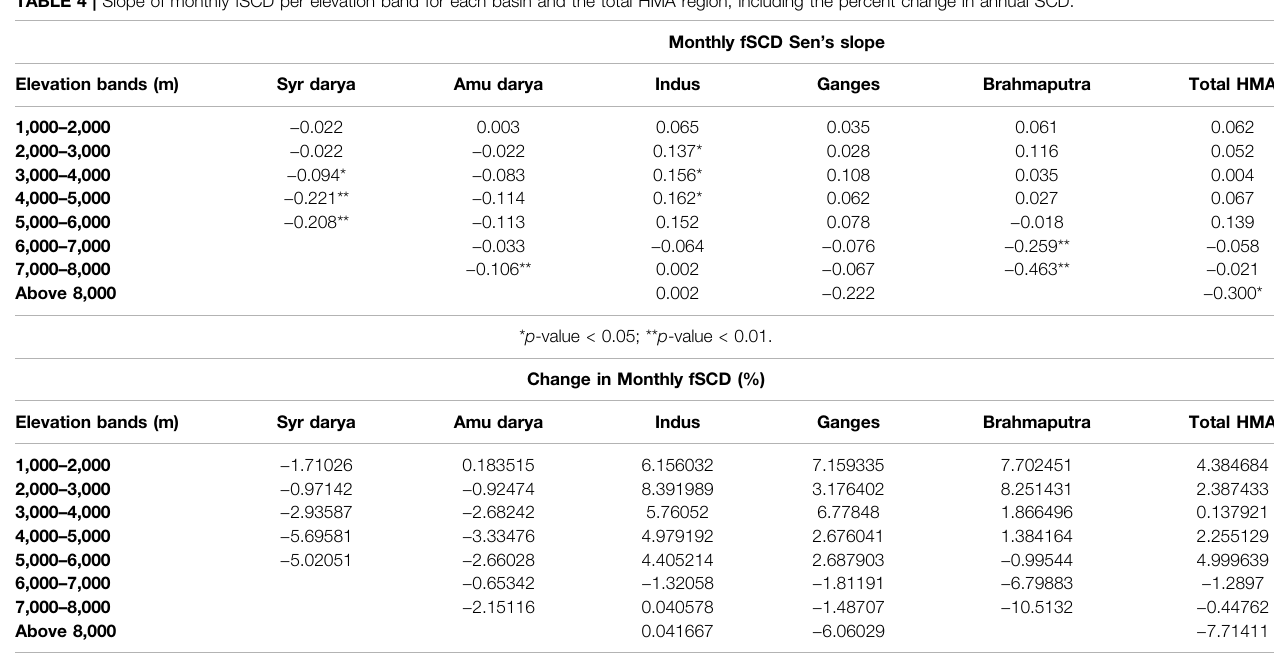
TABLE 4 | Slope of monthly fSCD per elevation band for each basin and the total HMA region, including the percent change in annual